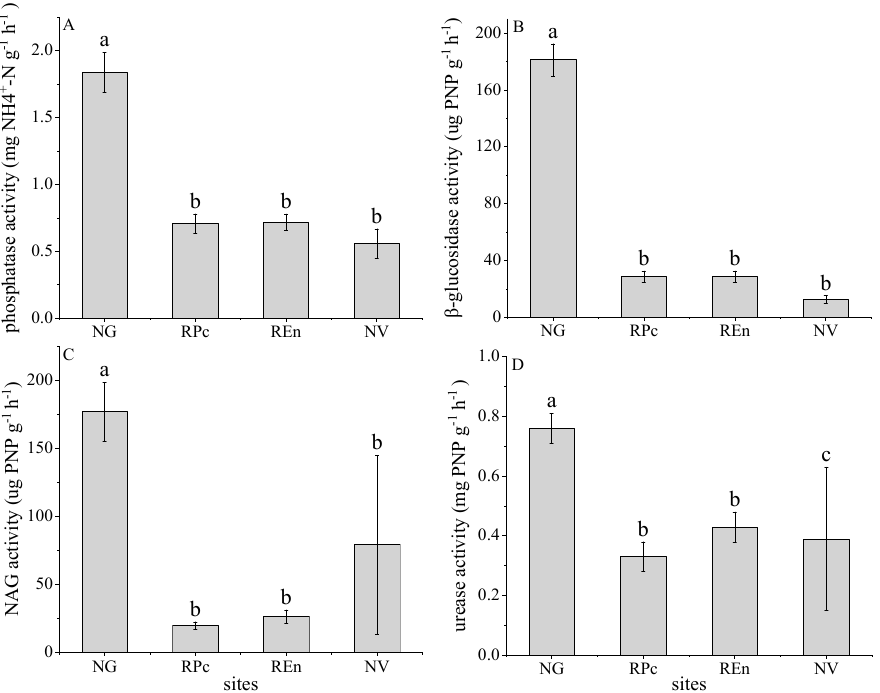
Figure 3. Phosphatase activities ( A ), β -glucosidase activities ( B ), β -1,4- N -acetylglucosaminidase activities (NAG) ( C ), u rease activities ( D ) in four sites. Different lowercase letters (a, b, c) indicate a significant difference under different restoration sites based on ANOVA ( p < 0.05).